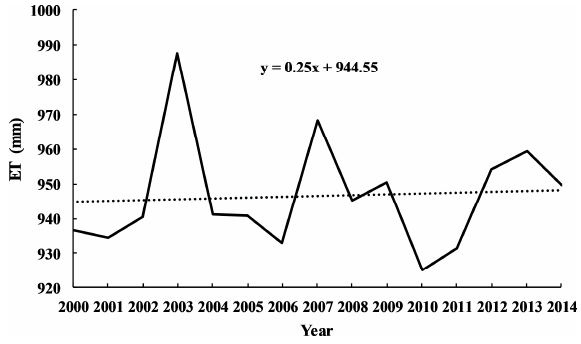
Figure 3. Variation in annual evapotranspiration (ET) in the Pearl River Basin (PRB) from 2000 to 2014.